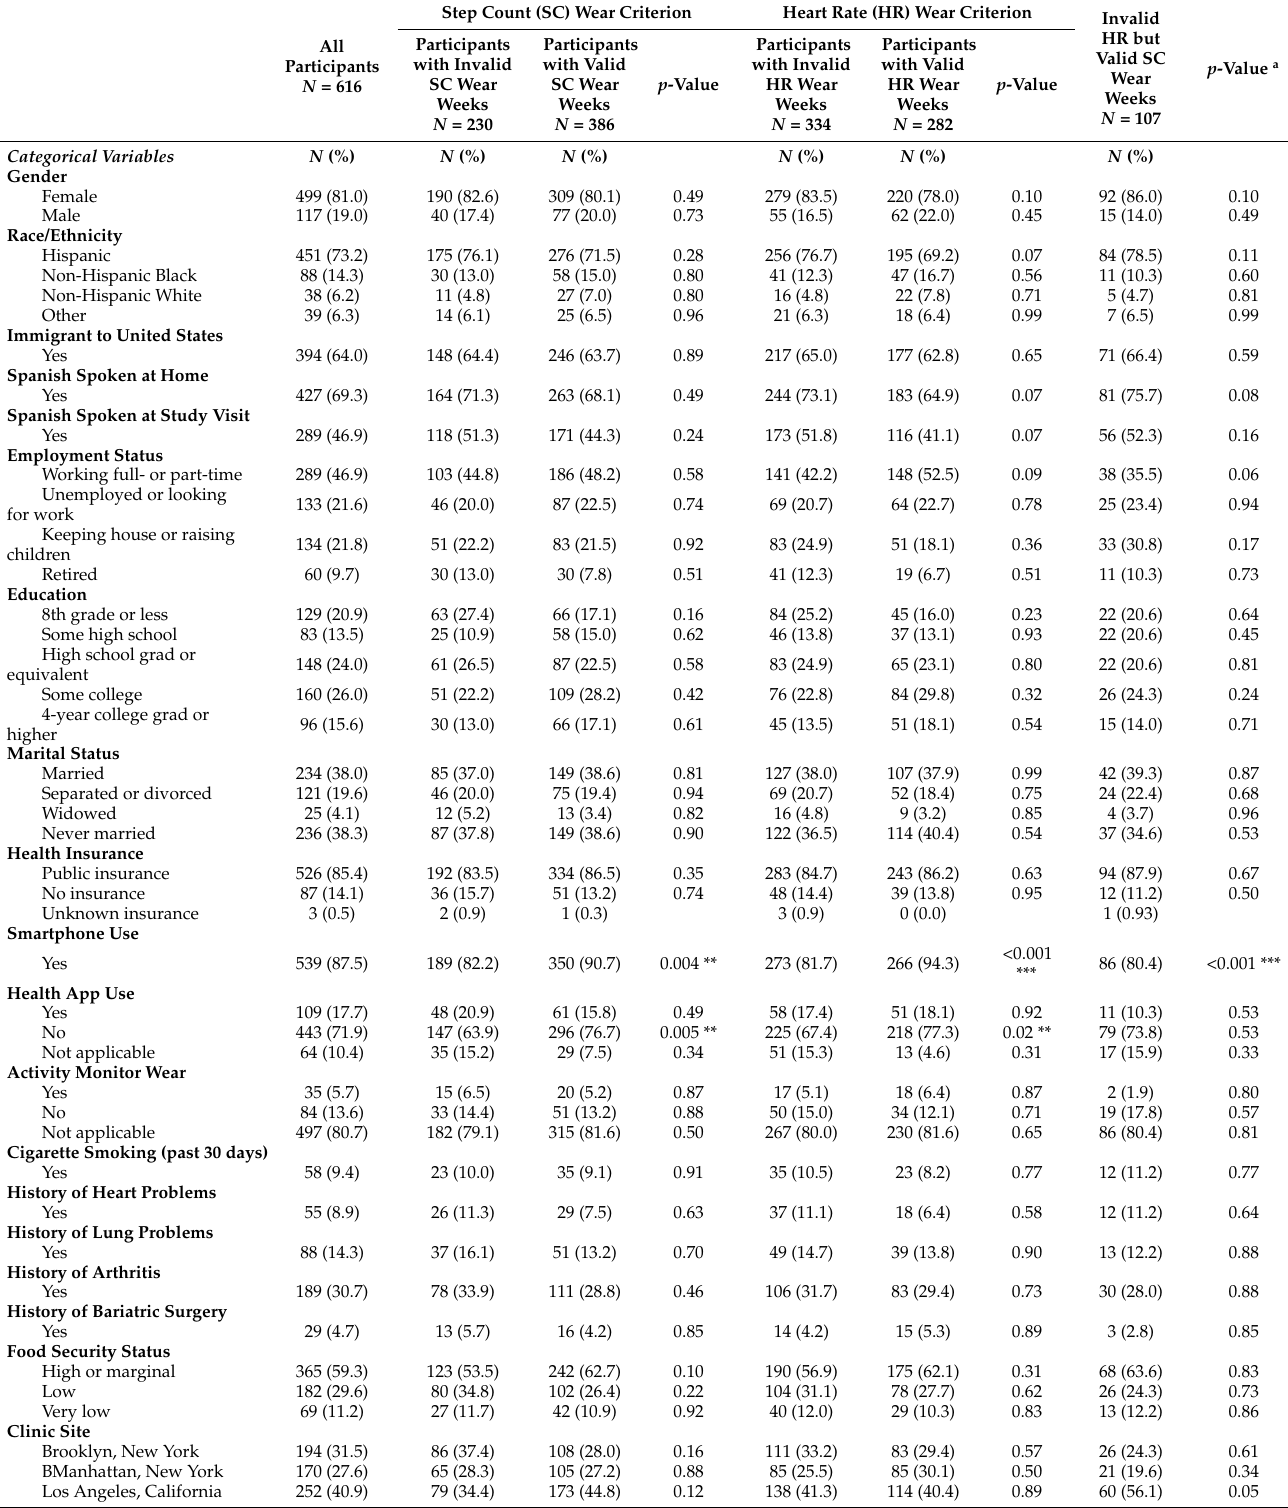
Table 1. Differences between groups with and without valid activity monitor wear in Weeks 1 and